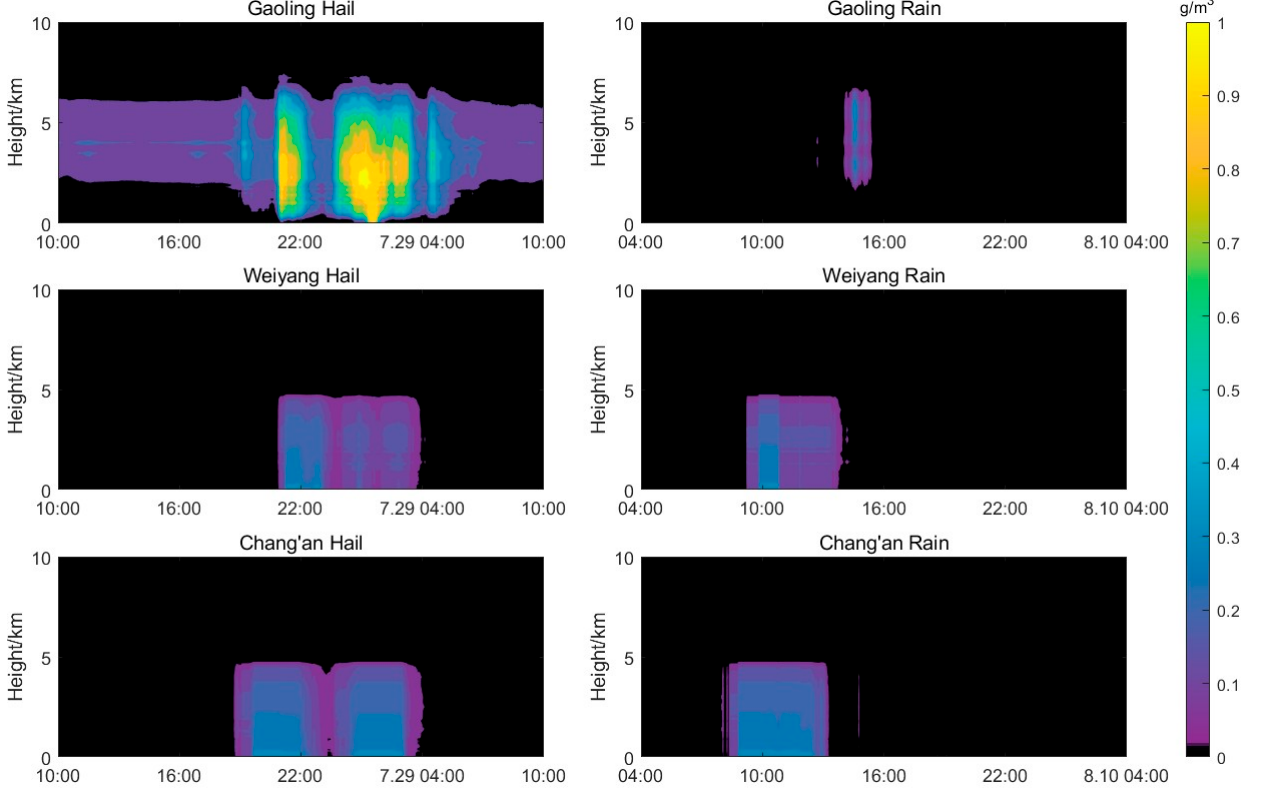
Figure 4. Changes in the liquid water profile during a hailstorm in the Gaoling, Weiyang, and Chang’an districts ( left , starting at 4:00 p.m. UTC on 27 July 2019) and rainfall ( right , rainfall process, starting at 4:00 p.m. UTC on 8 August 2018).